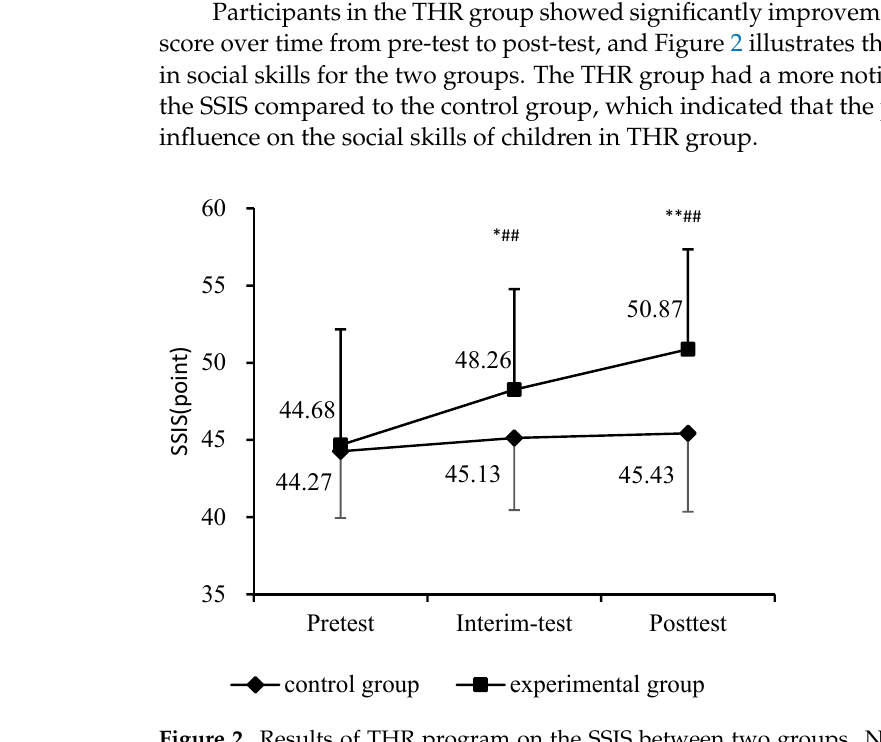
Figure 2. Results of THR program on the SSIS between two groups. Notes: Compared with the control group, * p < 0.05; ** p < 0.01. Compared with pre-test, ## p < 0.01